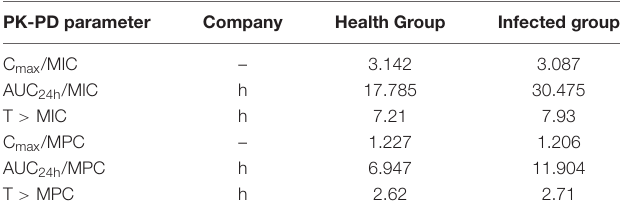
TABLE 3 | The PK-PD parameters of target organs in